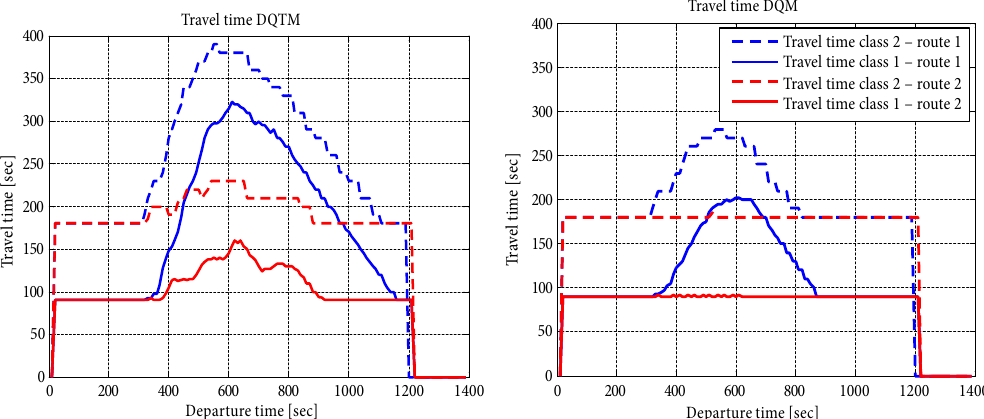
Fig. 7. Travel time for multi-class DQTM and